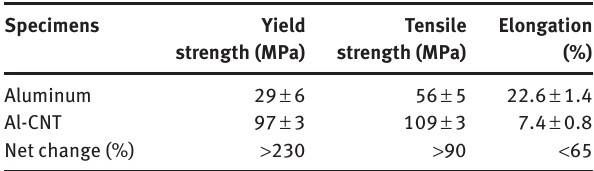
Table 2: Results of mechanical